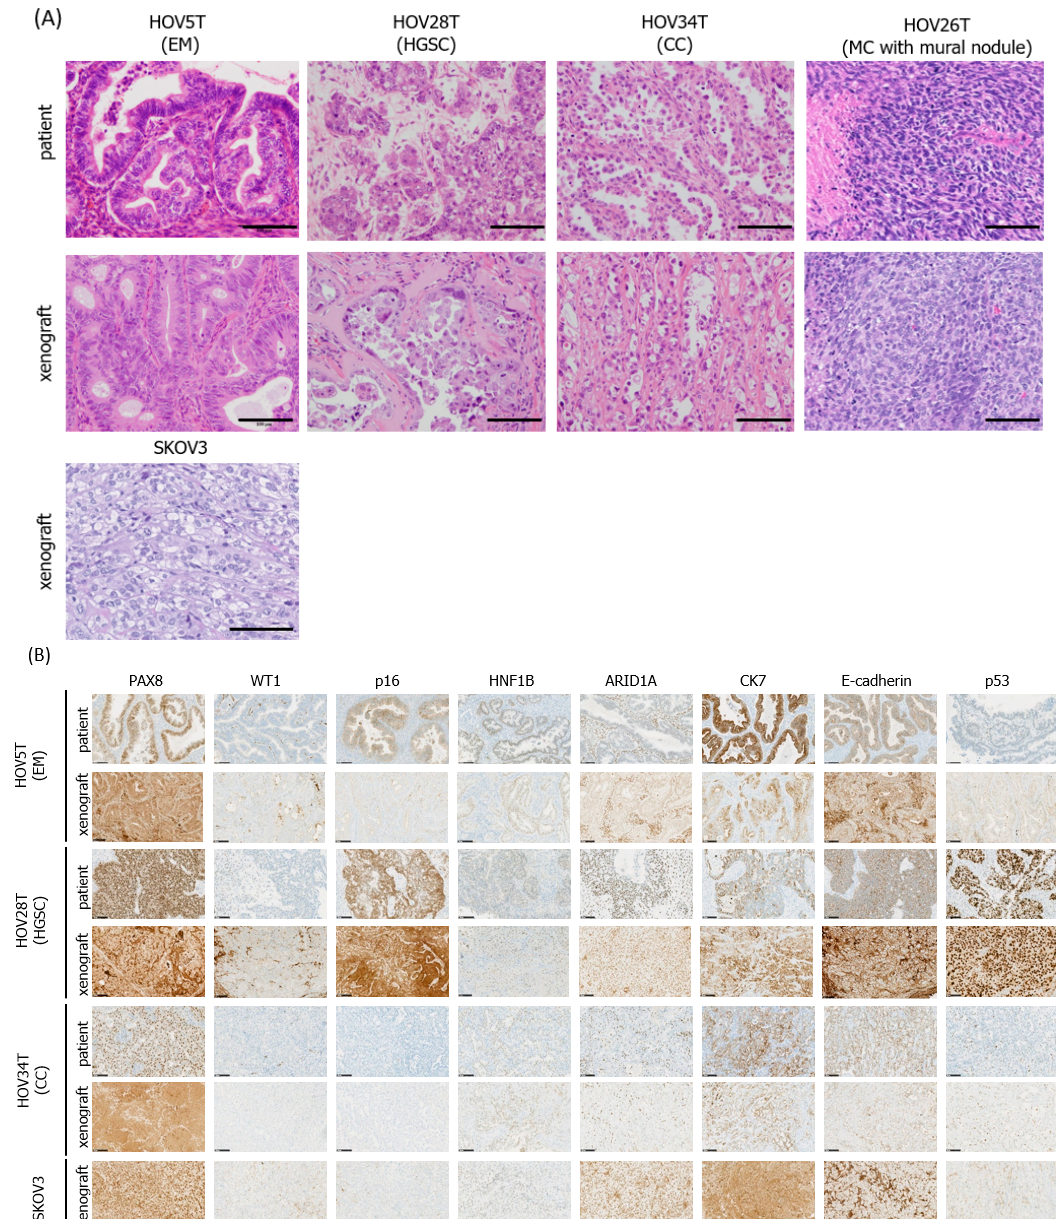
Figure 2. Recapitulation of original tumor tissue architecture and histotype-specific marker expression in xenografts of HOV cell lines. HOV lines and highly cited ovarian cancer cell line SKOV3 were subcutaneously injected to immunocompromised mice. ( A ) FFPE tissue sections from the xenograft tumors of HOV5T, HOV28T, HOV34T, and SKOV3 and original tumors corresponding to HOV cell lines were stained with hematoxylin and eosin. Representative microscopic images are shown. Scale bar 100 μ m. ( B ) FFPE sections of patient tumor tissue, HOV xenograft and SKOV3 xenograft were